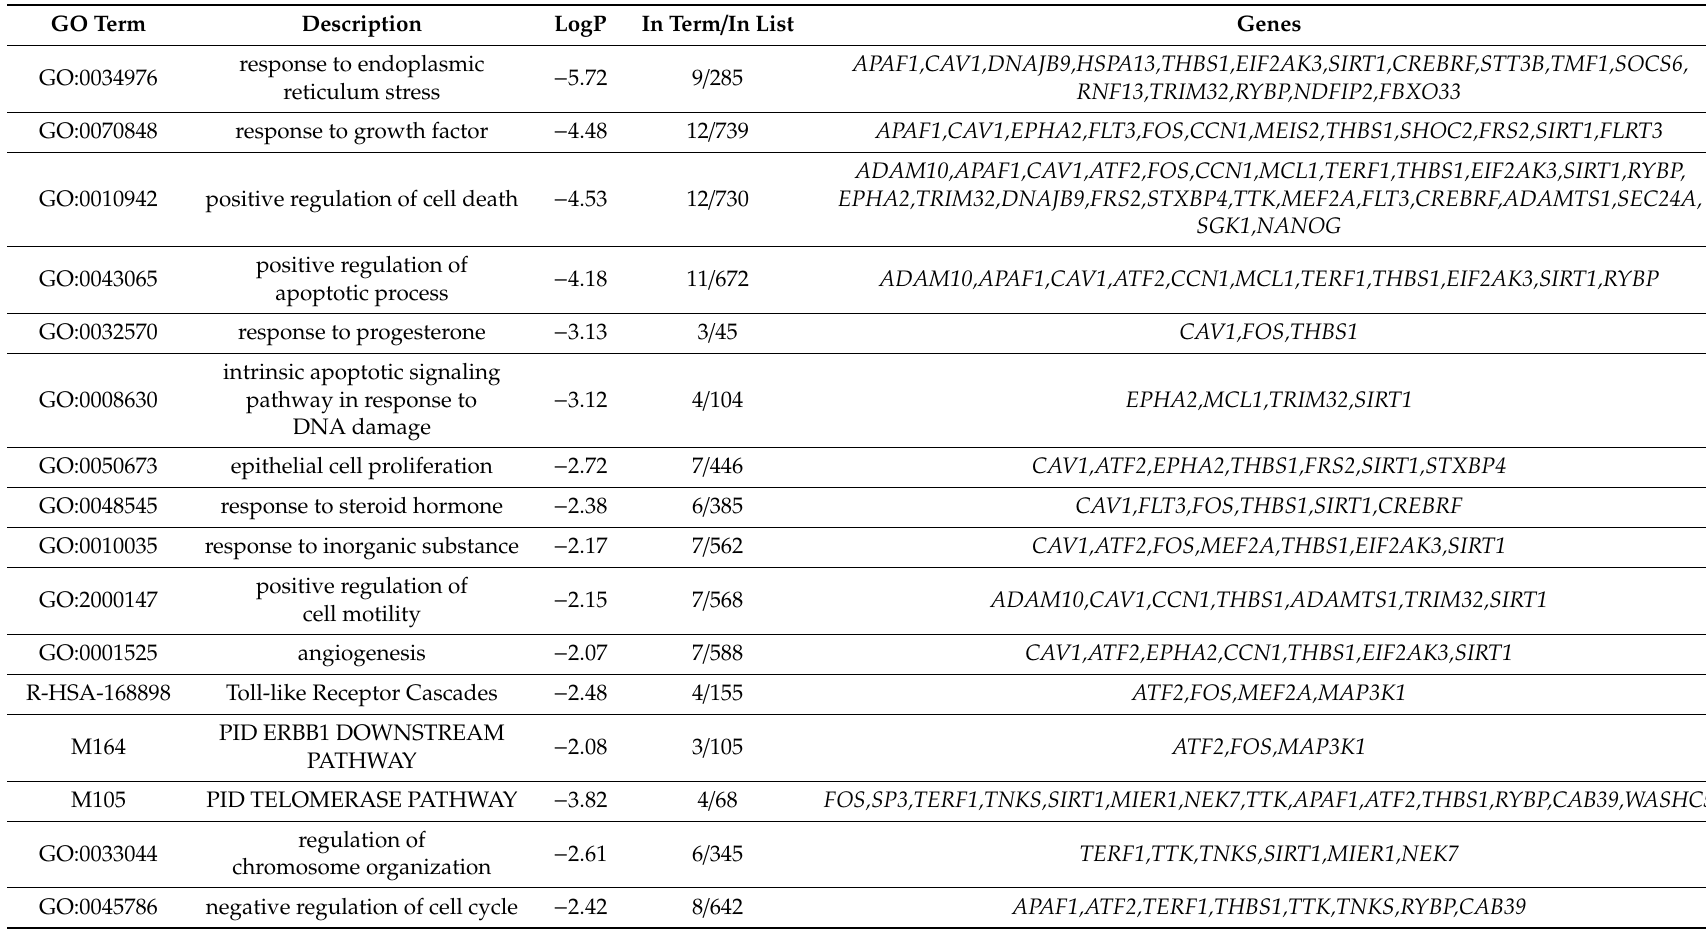
Table 1. Metascape functional annotation clusters for downregulated genes in embryos treated with FoEVs compared to